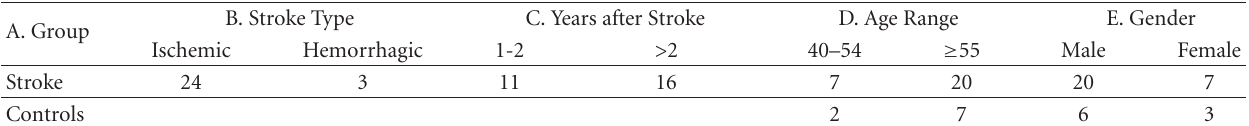
Table 1: Subject